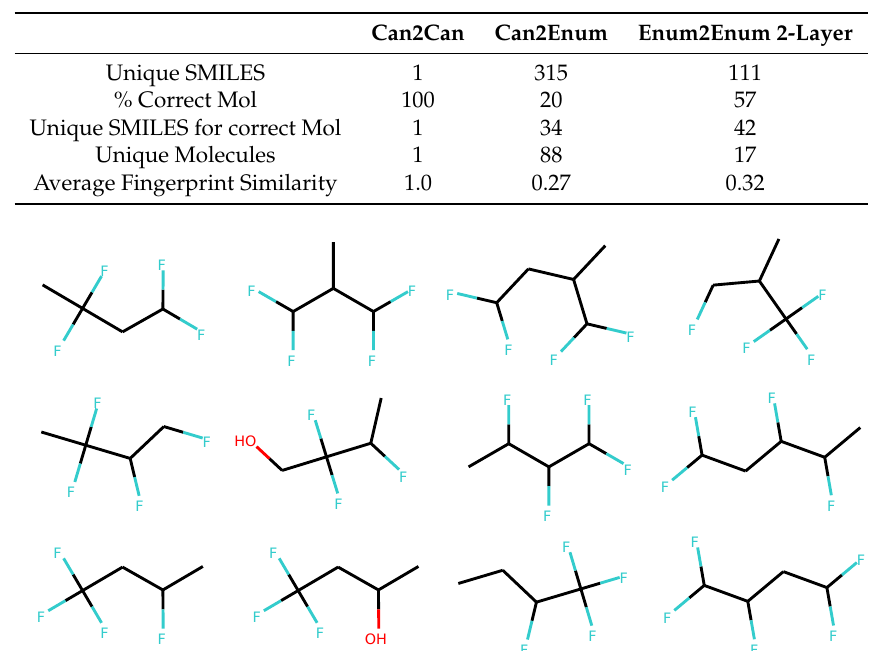
Figure 10. Multinomial sampling of the decoder for two different models illustrated with heat maps of the character probability for each step during decoding of the latent space. ( A ) the can2can model is very certain at each step and samples the same canonical SMILES each time; ( B ) the can2enum model has more possibilities at each step in the beginning. The probability heatmap and sampled SMILES will be different for each sampling run, depending on which character is chosen from the probability distribution at each step. Table 2. Statistics on molecule generation with multinomial sampling at t = 1.0, n = 1000, GDB-8 dataset based models.